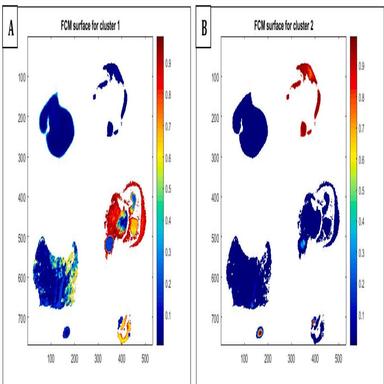
Fuzzy C-Means (FCM) clustering analysis of the NMI region at ambient temperature. Clusters 1 through 4 are visualized in panels A to E, respectively, with the membership probabilities indicated by the color scale. Panel C presents the centroid spectra for each cluster, with lines corresponding to the cluster numbers shown in panels A, B, D, and E.